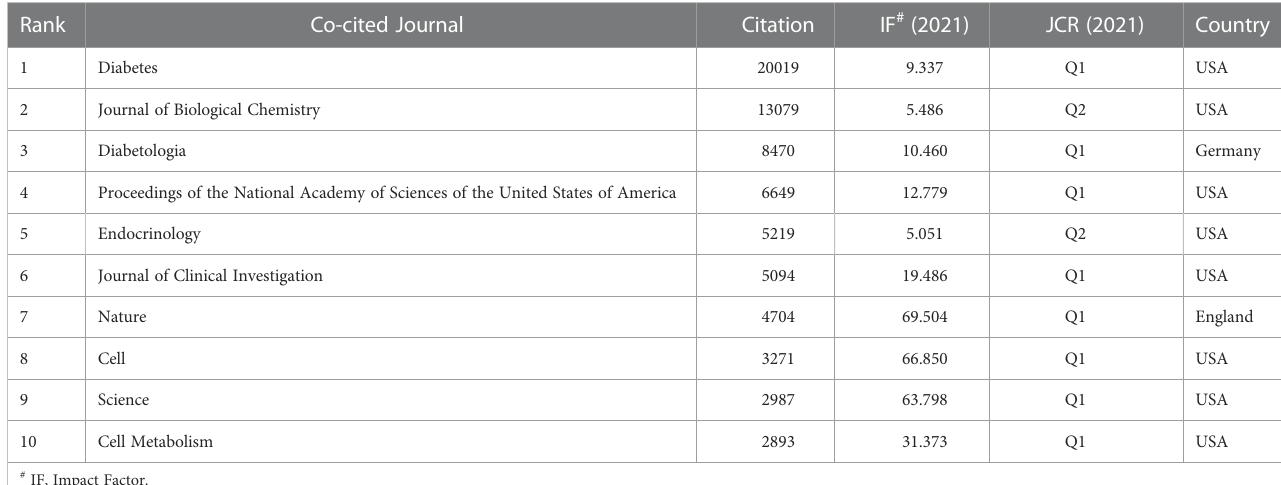
TABLE 4 Top 10 co-cited journals related to beta-cell research.